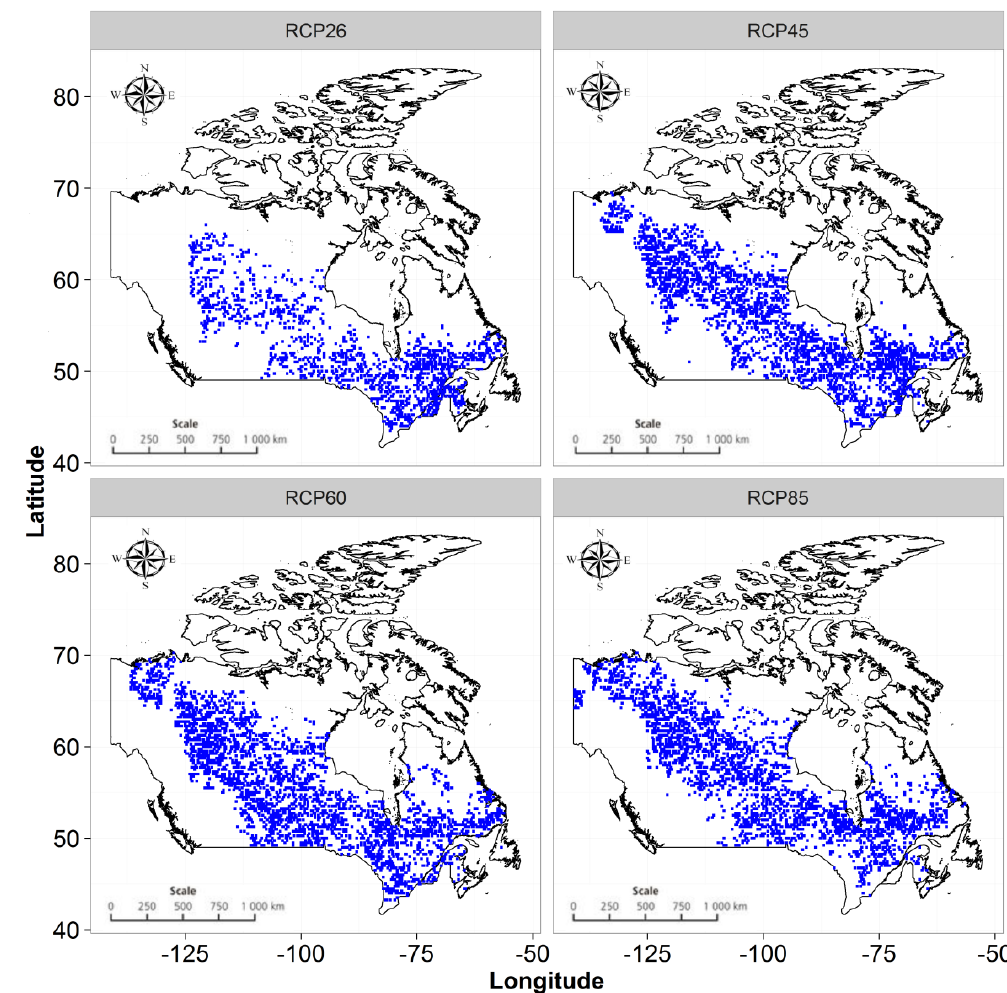
Figure 9. Grids that are projected with up to two months of earlier onset of spring-time extreme flow.